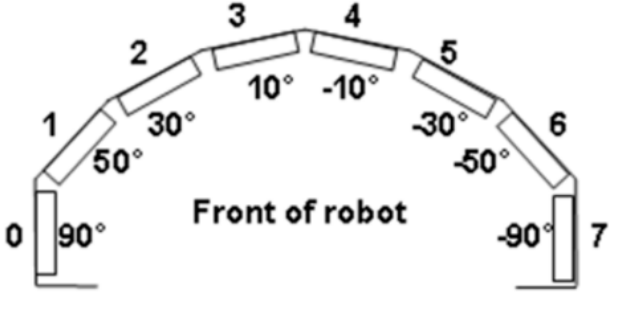
Figure 10. Placement of sonar sensors near our robot’s base.